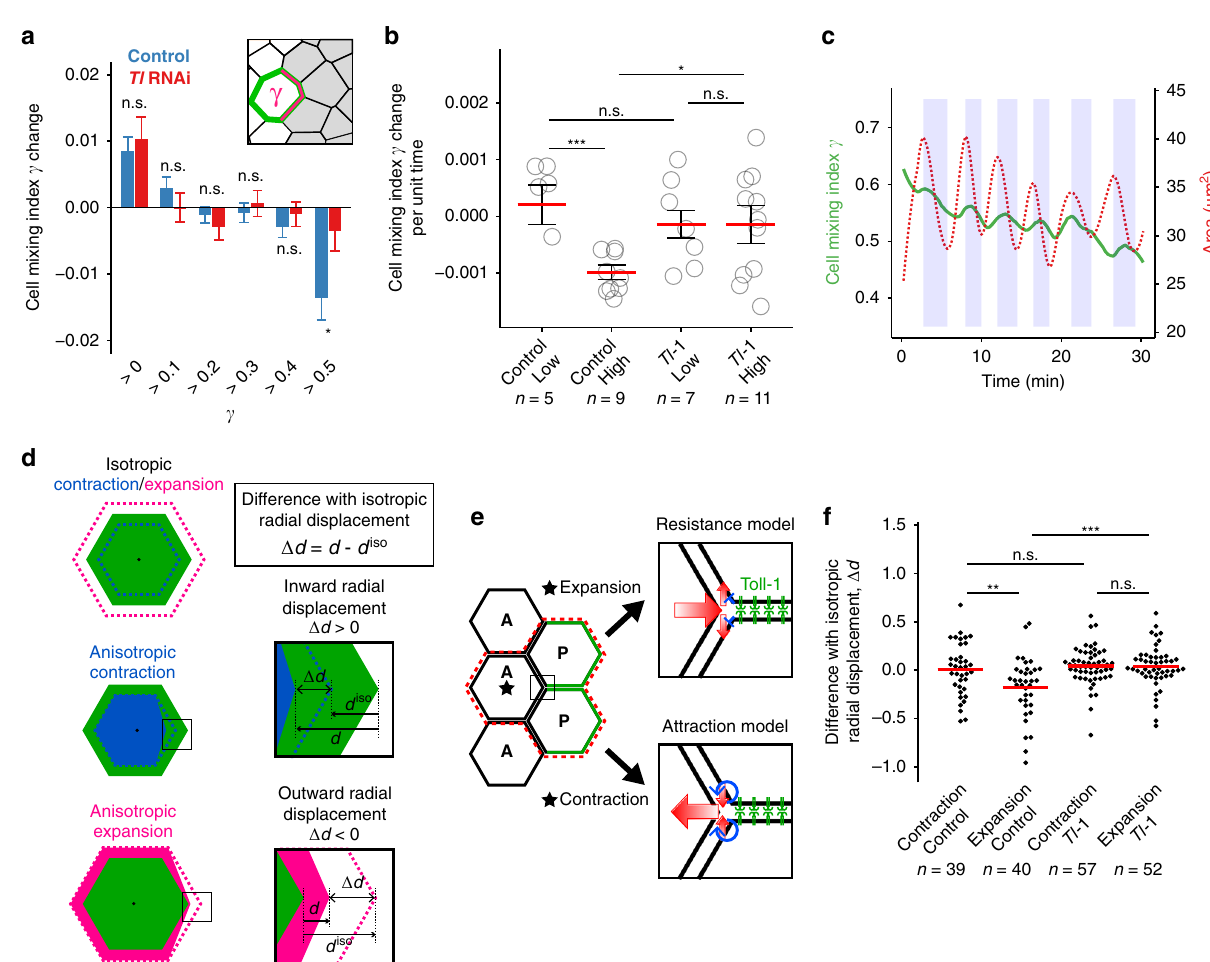
Fig. 5 Trans interaction of Toll-1 between P histoblasts increases homotypic cell contacts by biasing the vertex sliding. a The reduction of cell mixing index γ at the locally distorted AP boundary is dependent on Tl . Cell mixing index γ is the fraction of the adherent ’ s junctional length of cells that are in contact with cells of the adjacent compartment. Change in γ between two frames (3 min) was measured for individual cells categorized by the value for γ at the fi rst frame. Totally, 1220 cells (107, 240, 346, 251, 211, and 65 cells for >0, >0.1, >0.2, >0.3, >0.4, and >0.5 bins, respectively) from 6 boundaries for control and 964 cells (91, 176, 204, 241, 189, 63 cells for >0, >0.1, >0.2, >0.3, >0.4, >0.5 bins, respectively) from 5 boundaries at the proliferation phase (21 – 23 hAPF) were analyzed. Data are presented as mean values± SEM. p Values were from the Student ’ s t test (unpaired, two-sided). * p < 0.05. b Cells with higher area fl uctuation reduce γ ef fi ciently in control but not in Tl knockdown tissue. The analysis was performed for A cells having γ > 0.5 (10 animals for control and 15 animals for Tl knockdown at the proliferation phase (21 – 23 hAPF)). Cells were categorized as low or high fl uctuation based on the degree of area fl uctuation (see “ Methods ” ) and were analyzed for γ change separately. Statistical analysis was performed using the lm function in R (version 4.0.0). The number of analyzed cells were indicated as n . Data are presented as mean values ± SEM. Statistical signi fi cance was determined using a Mann – Whitney U test (two-sided). * p < 0.05, *** p < 0.001, and n.s. not signi fi cant. c The cell mixing index γ declines as the area of the cell fl uctuate. The cross-sectional area and γ for an A cell that has initially high γ were plotted as a function of time. d Measurement of vertex sliding productivity at the AP boundary during contraction and expansion. The two possible situations that would result in the straightening of the AP boundary are illustrated. The productivity of vertex displacement was evaluated by comparing cells ’ displacement behavior to the hypothetical vertex displacement that they would undergo if the cell exhibited isotropic cell shape change with the same degree of area change ( Δ d ). Δ d is calculated by subtracting the calculated displacement of the vertex ( d iso ) when the isotropic contraction was supposed from the actual displacement ( d ) of the vertex on the AP boundary for A cells for the expansion phase and contraction phase, separately. e Two models illustrating the homophilic interaction of Tl regulating vertex sliding at the interface between A and P histoblasts. The analyzed cell con fi guration is shown on the left (one A cell and two P cells, highlighted with red dashed line). Large red arrows indicate the direction of vertex sliding; small red arrows indicate the direction of the forces exerted on the cell – cell contact between P cells, which result in either separation (top) or closure (bottom) of homotypic cell – cell contacts between P cells. Blue arrows represent the recruitment of more Tl at the leading edge of the cell – cell contact between P cells. f Tl was required for the biased outward vertex sliding for A cells at the AP boundary. Δ d was plotted for cells that initially had a high γ value ( γ > 0.55) at each area expansion and contraction phase separately (three cells each for control and Tl knockdown) from the pupae at the proliferation phase (21 – 23 hAPF). Outward sliding was less effective than expected from hypothetical isotropic vertex displacement in controls. Inward sliding was comparable to the hypothetical isotropic vertex displacement. The outward vertex sliding became unbiased in the Tl knockdown tissue. The numbers of analyzed phases (contraction or expansion) were indicated as n . Statistical signi fi cance was determined using a Student ’ s t test (unpaired, two-sided). ** p < 0.01, and *** p <